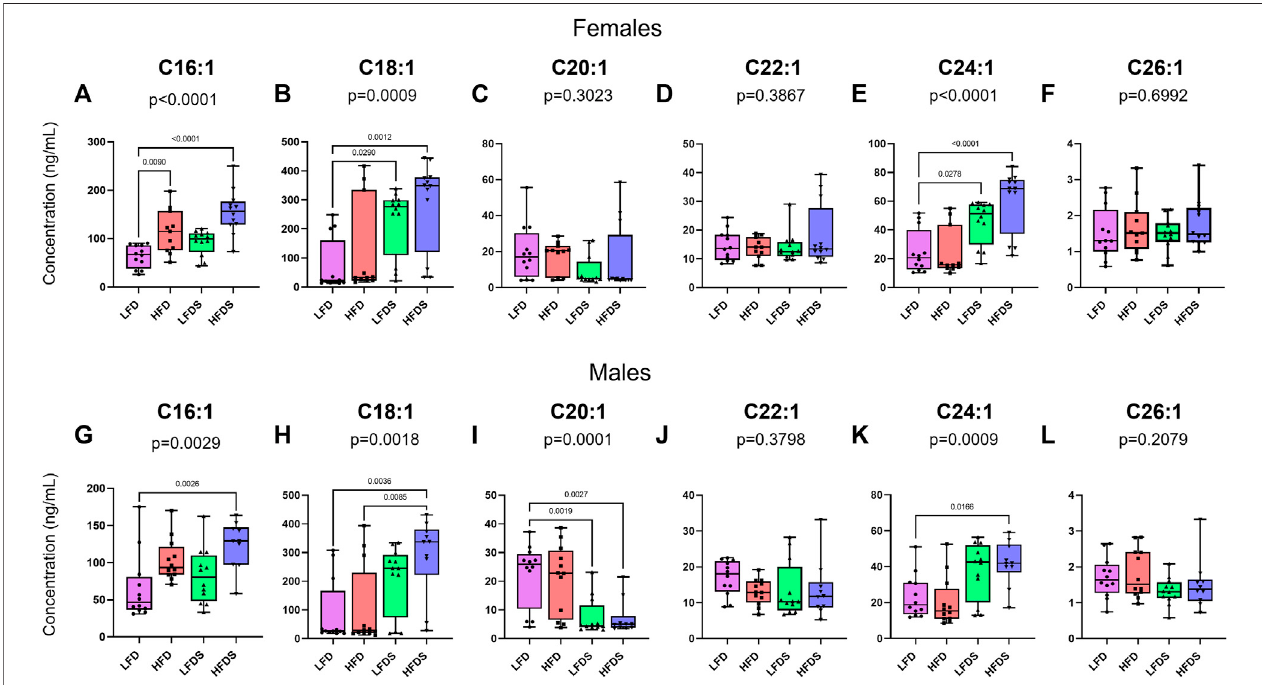
FIGURE 4 | Ceramides with one unsaturated acyl chain in blood serum after HFD and/or STU stress. (A – F) Long-chain ceramides in blood serum from female rat groups. (G – L) Long-chain ceramides in serum of male rats. Data represented as mean ± SEM. Female sample sizes: LFD = 12, HFD = 11, LFDS = 12, and HFDS = 12. Male sample sizes: LFD = 12, HFD = 12, LFDS = 12, and HFDS = 10. Statistic used, One-way ANOVA with Tukey ’ s multiple comparison